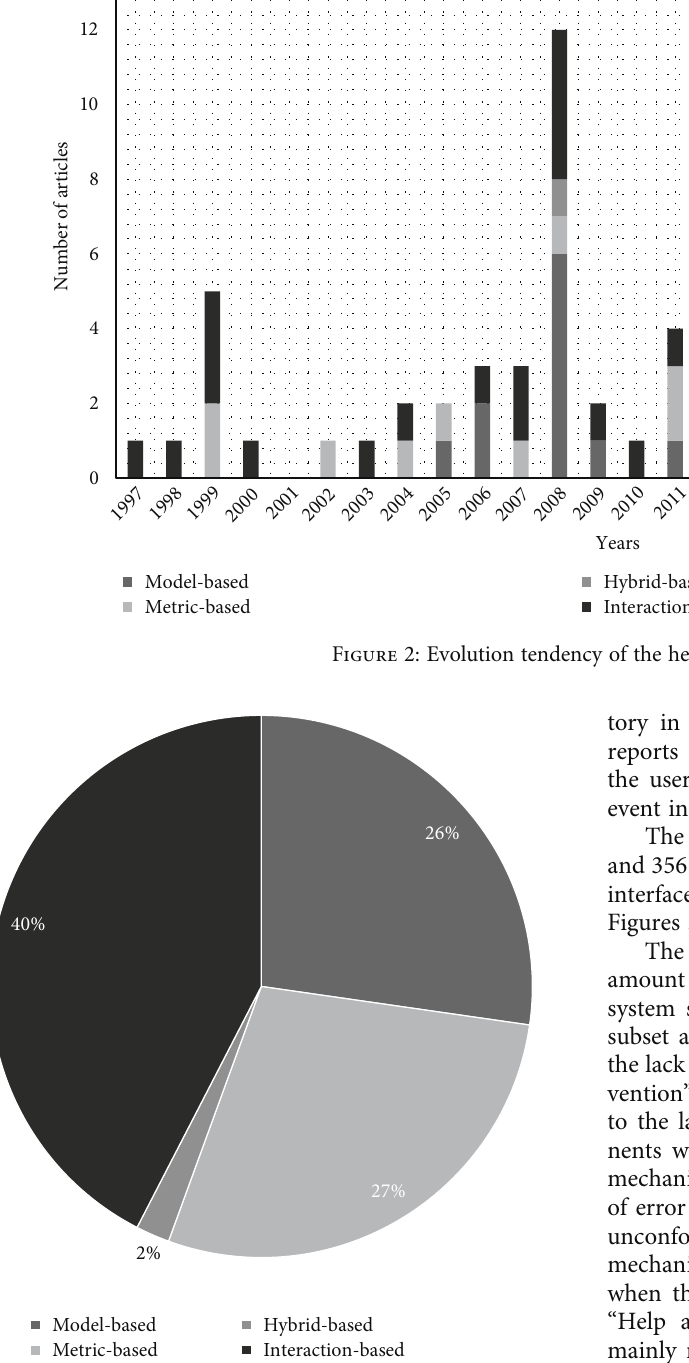
Figure 3: Distribution of heuristic solutions category